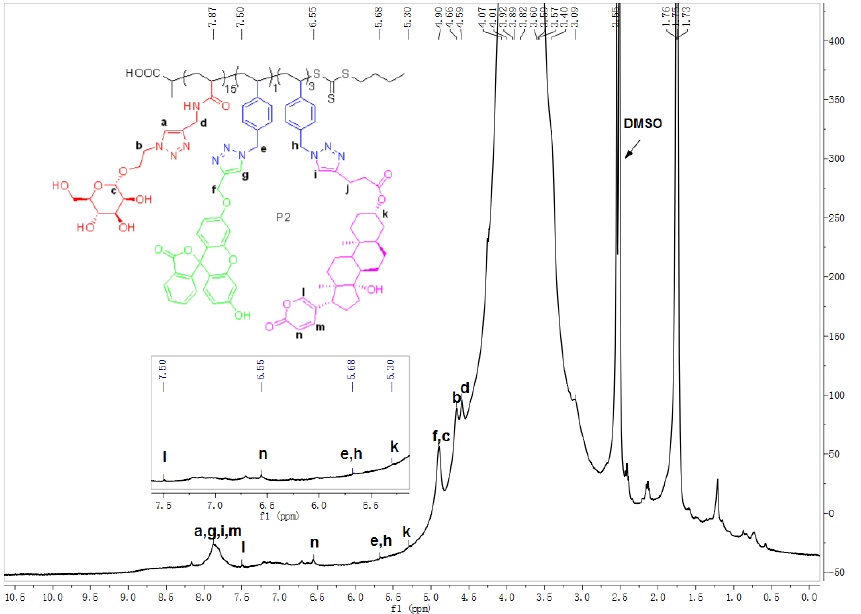
Figure 1. 1 H spectrum of polymer–buf conjugate P2 recorded in d 6